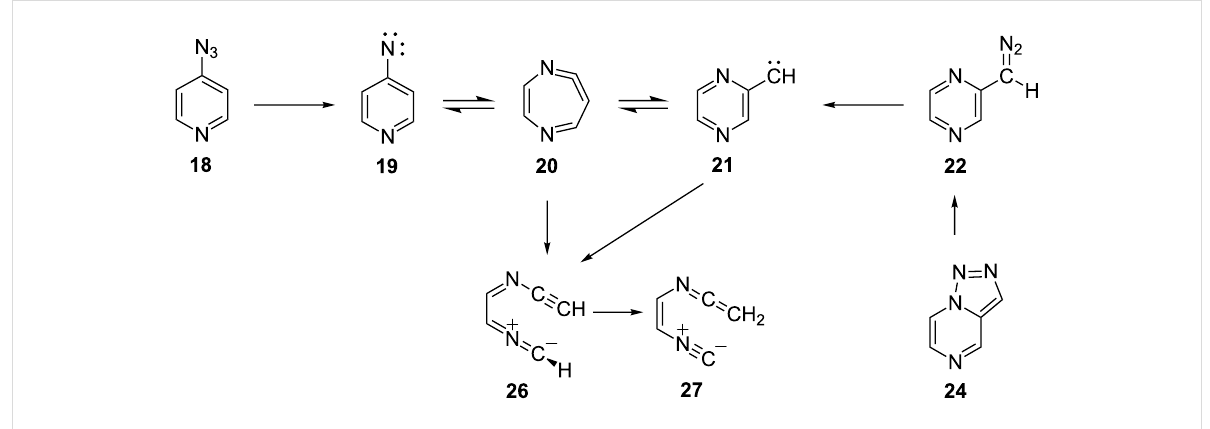
Scheme 4: Photolysis reactions of azide 18 and triazole 24 in Ar